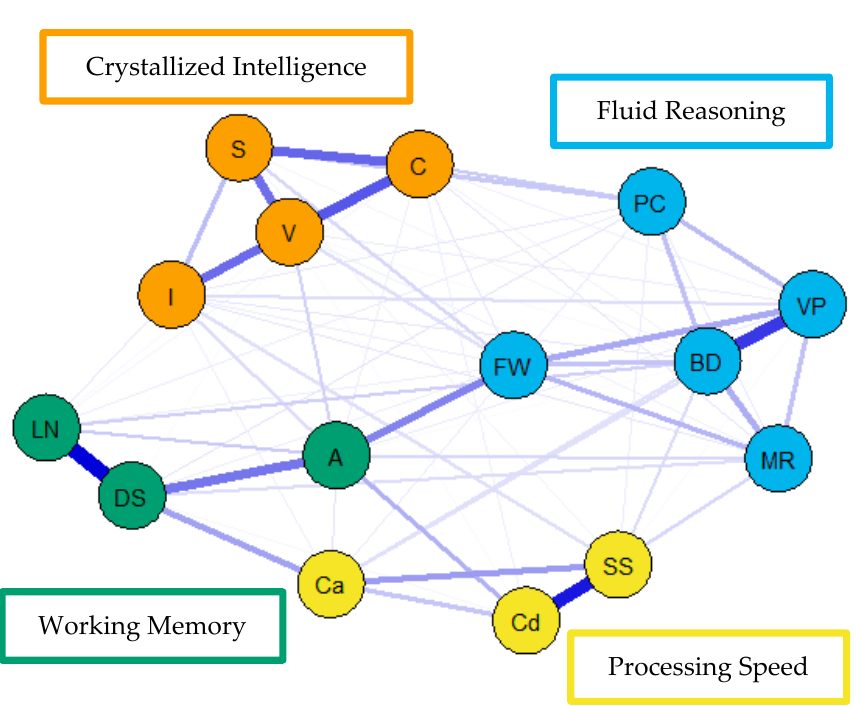
Figure 4. Weighted, undirected psychometric network model of the young group WAIS-IV correlation matrix. BD = block design; S = similarities; DS = digit span; MR = matrix reasoning; V = vocabulary; A = arithmetic; SS = symbol search;